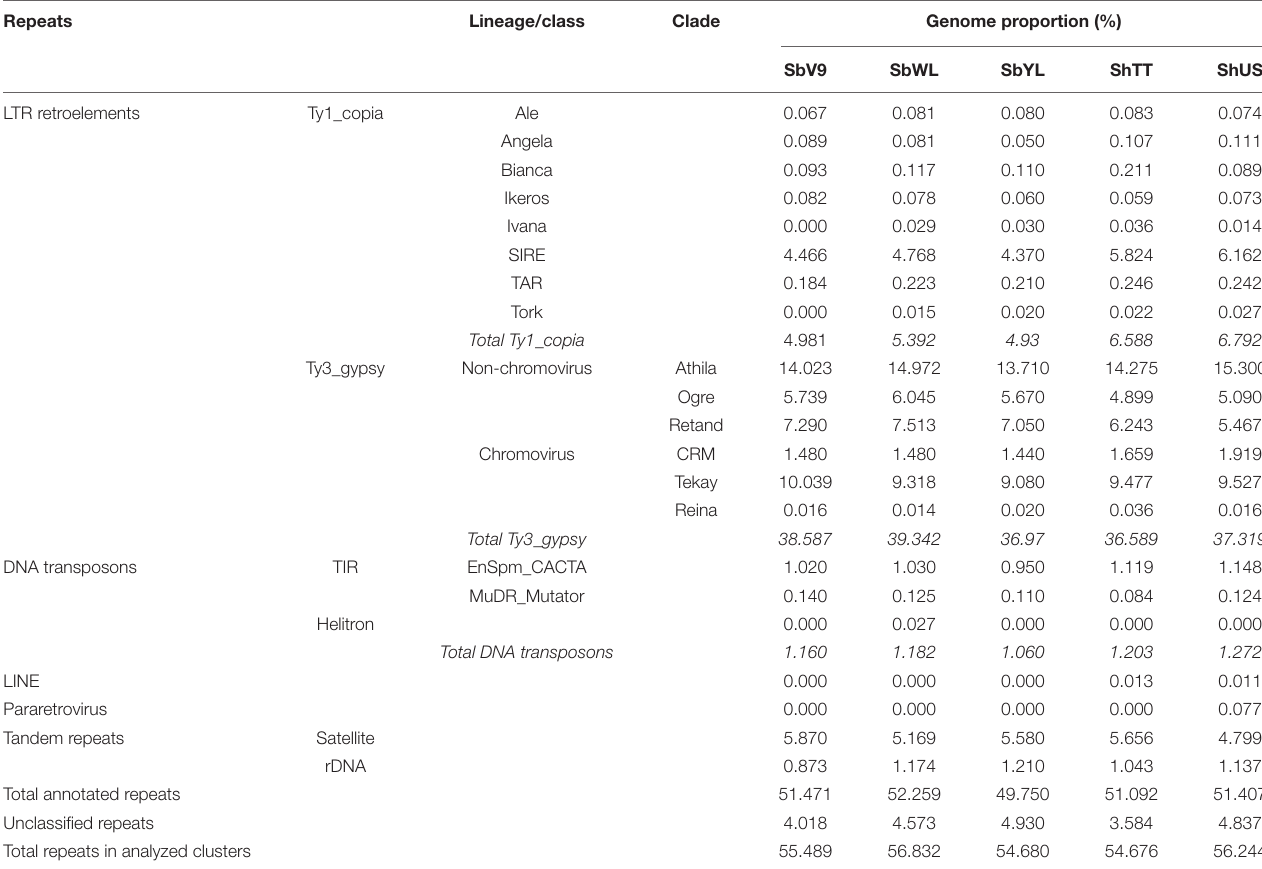
TABLE 2 | The proportion of moderate and high-copy repetitive DNA in the five Sorghum genomes.